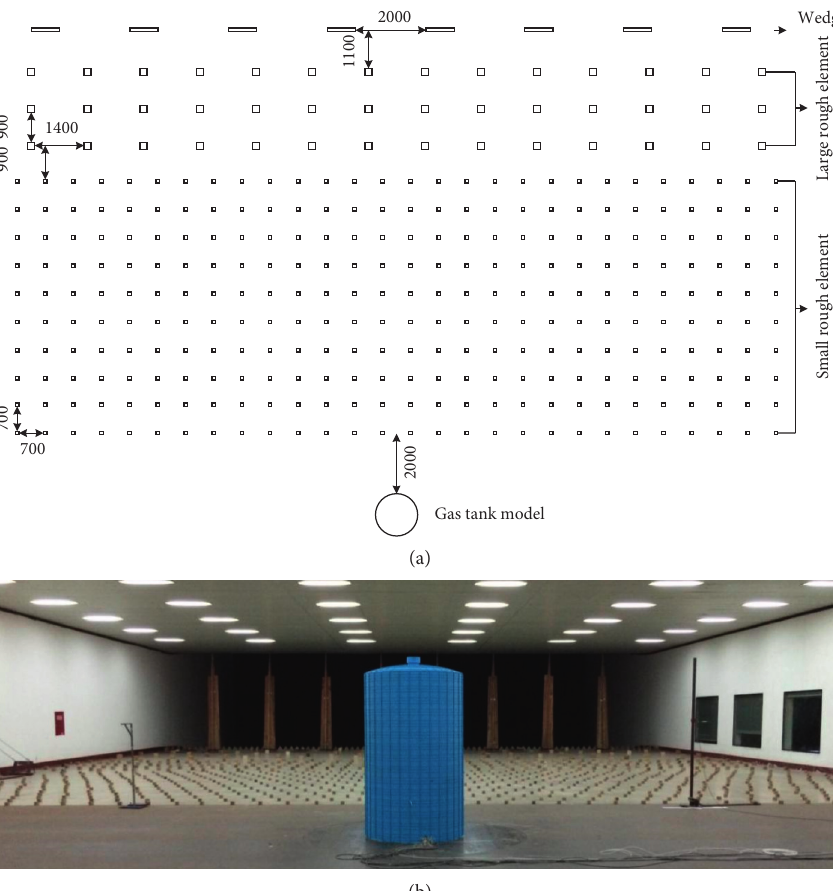
Figure 5: Arrangement of wind field. (a) Layout of turbulent field (unit: mm). (b) Realistic arrangement of turbulent field.